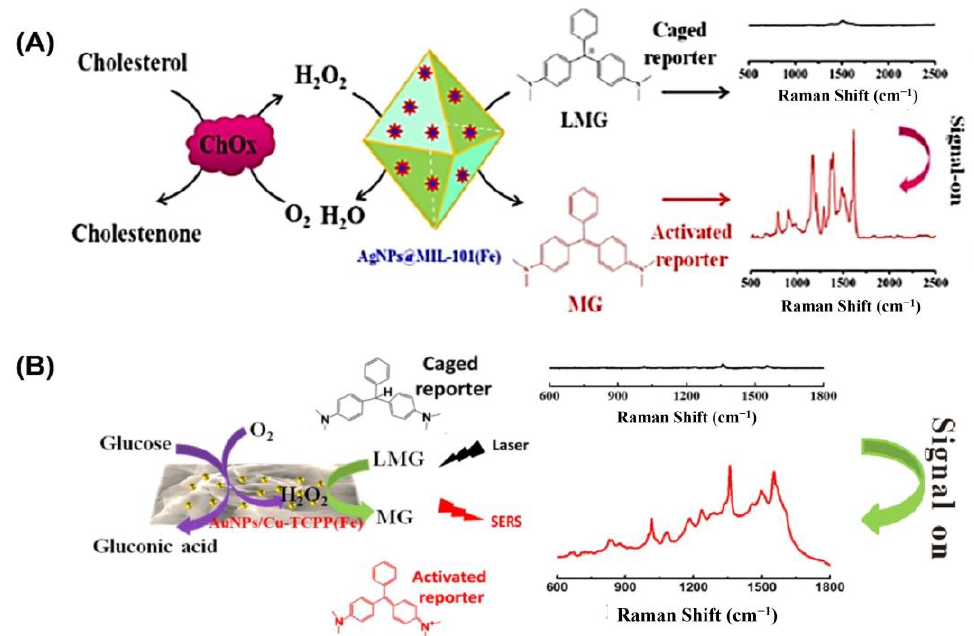
Figure 6. ( A ) Illustration of the cholesterol-detecting SERS biosensor based on AgNPs@MIL-101(Fe). ( B ) Schematic representation of the enzyme-free tandem reaction method for SERS glucose meas- urement. Reprinted with permission from refs.[87,88] .